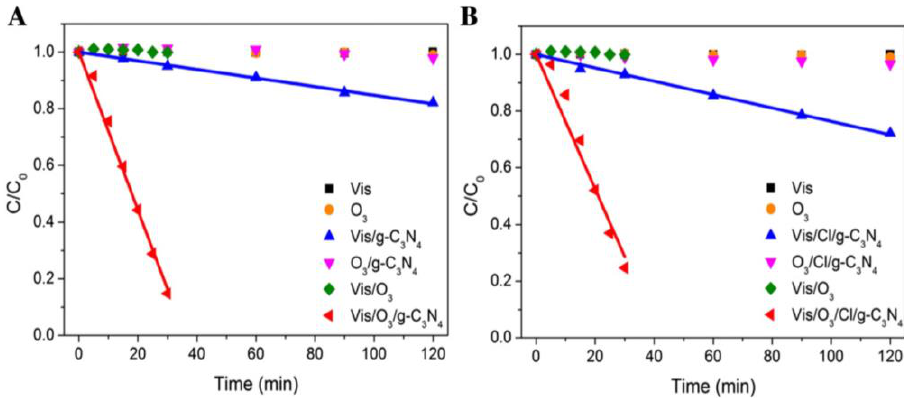
Figure 6. Degradation of OA by various oxidation processes upon g-C 3 N 4 ( A ) and Cl/g-C 3 N 4 ( B ). Reproduced with permission from ref. [57]. Copyright 2015 Elsevier.